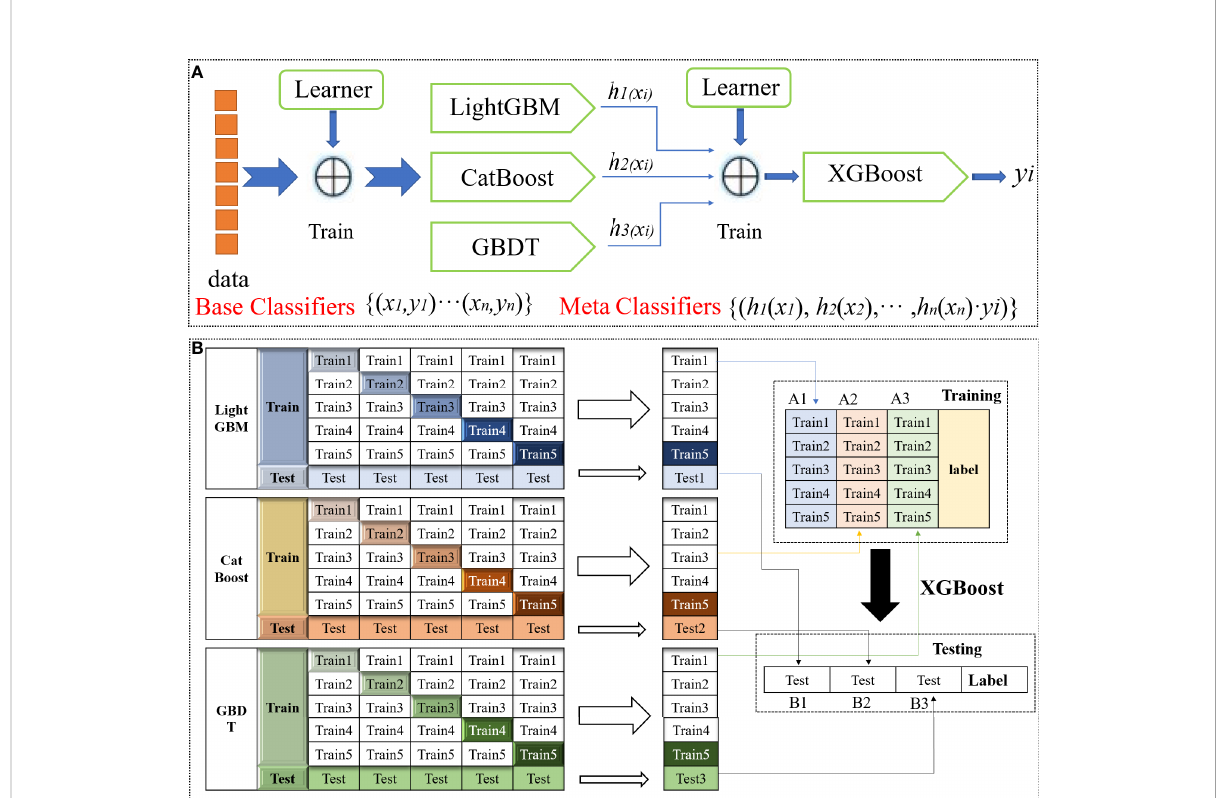
FIGURE 3 Schematic diagram of the SEL. (A) SEL schematic diagram. (B) SEL principle fl ow